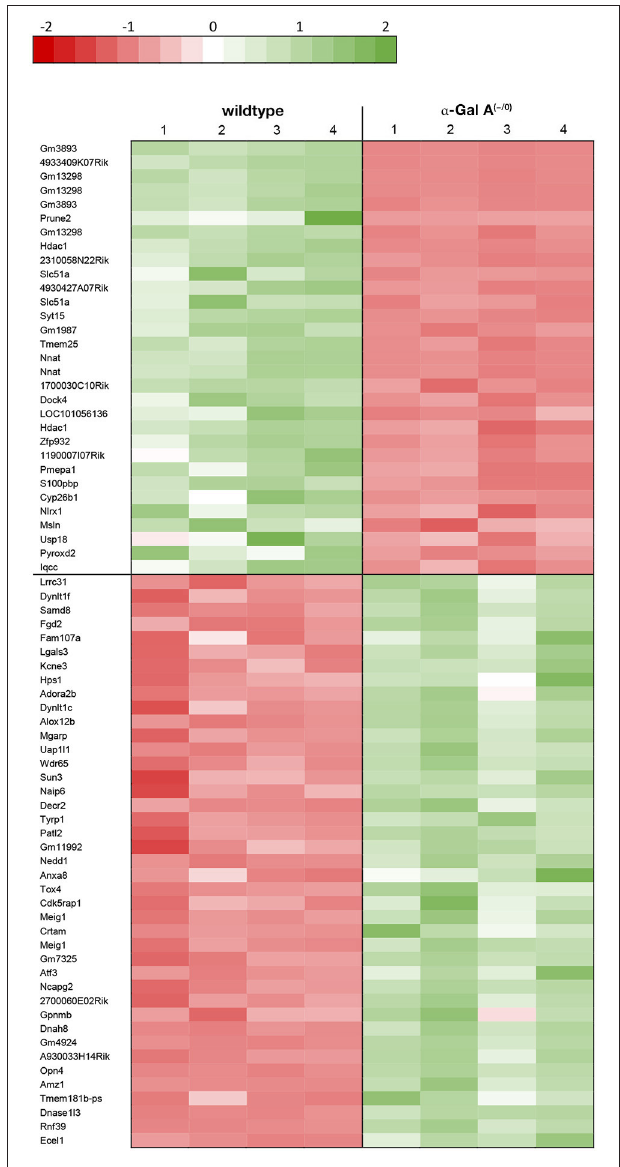
FIGURE 2 | Heatmap of significantly regulated